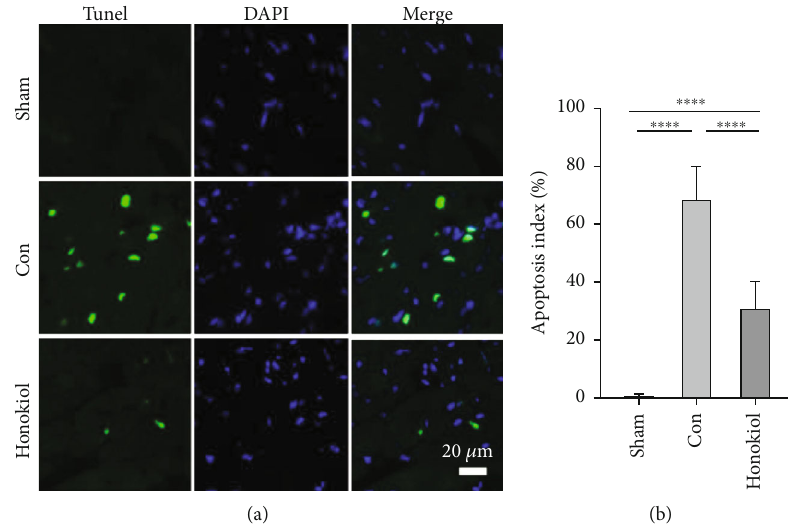
Figure 4: Assessment of cardiomyocyte apoptosis. The TUNEL assay was utilized to evaluate cardiomyocyte apoptosis in ventricular tissue (400x, n = 7 per cohort). Data are articulated as mean ± SEM . ∗∗∗ ∗ p < 0 : 0001